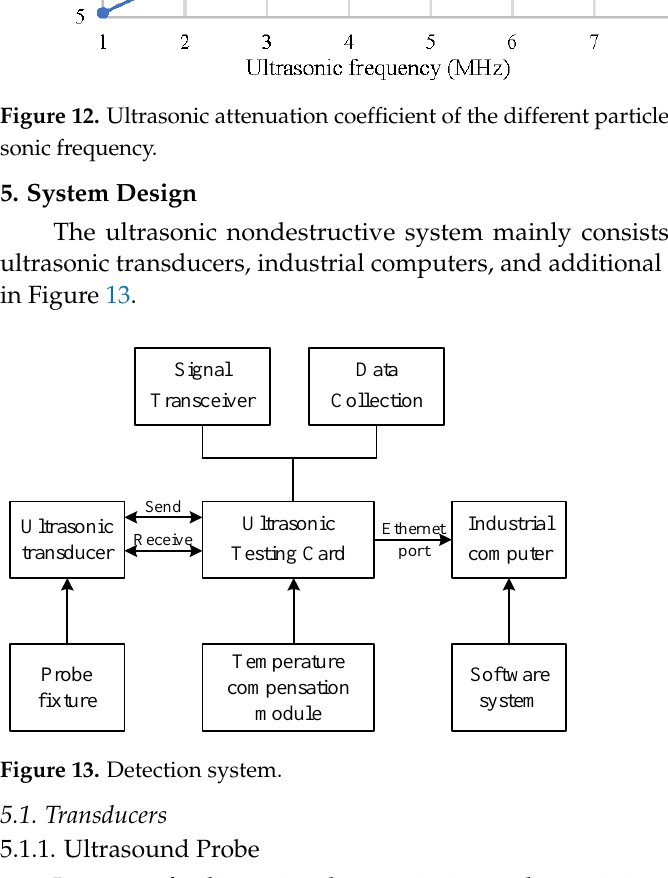
trasonic frequency.